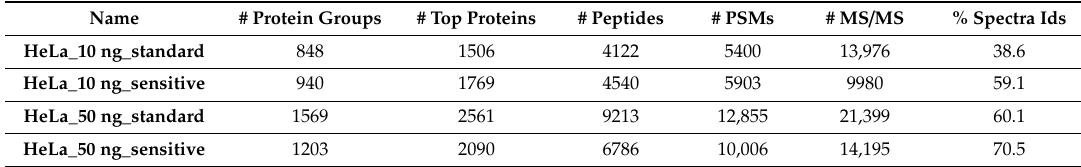
Table 2. Summary of the number (#) of identified non-redundant protein and peptide groups as well as the number of peptide spectrum matches (PSMs) and MS / MS events acquired with two di ff erent acquisition methods and two di ff erent protein